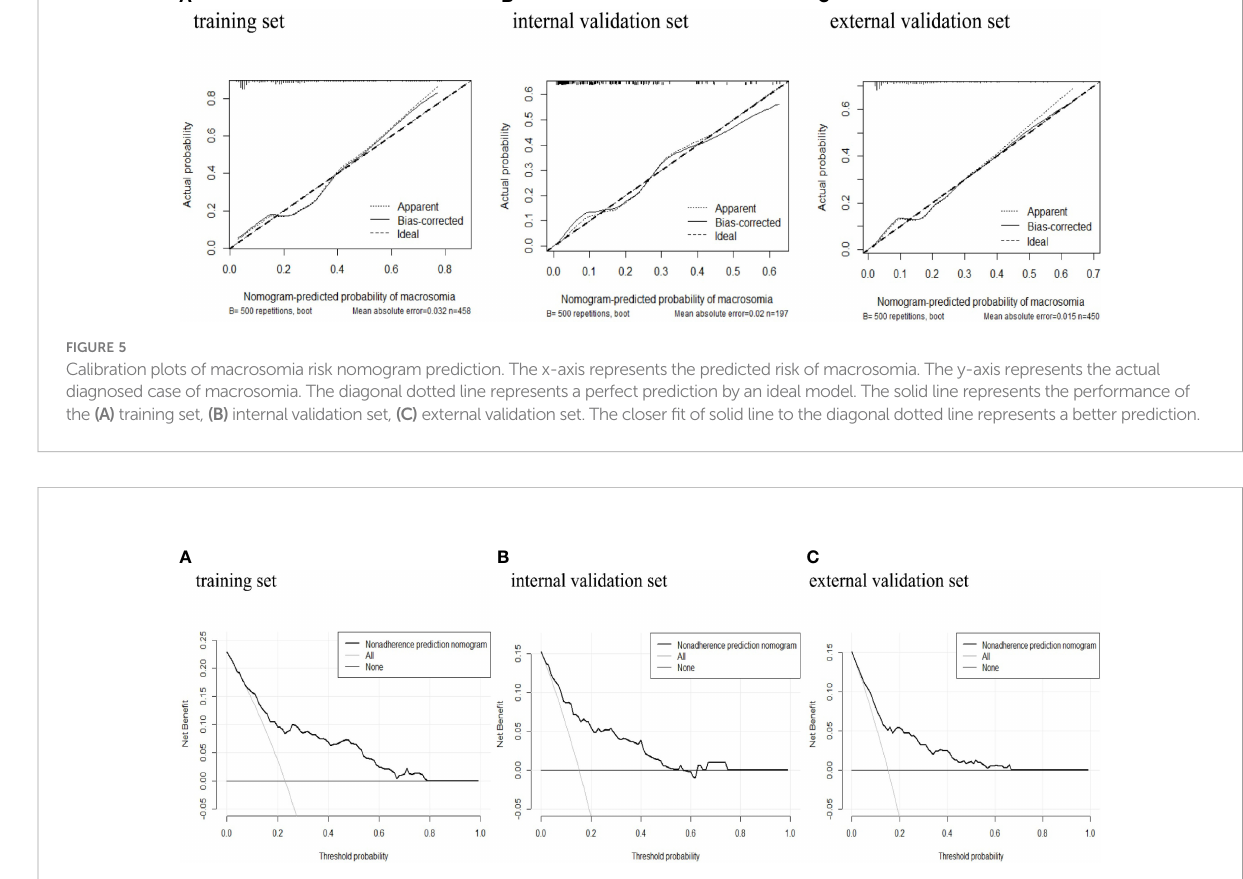
FIGURE 6 Decision curve analysis of macrosomia risk nomogram prediction. DCA of the (A) training set, (B) internal validation set, and (C) external validation set. The x-axis measures the threshold probability. The y-axis measures the net bene fi t. The thick, black solid line represents the macrosomia risk nomogram. The thin, black horizontal line (none line) represents the assumption that no patients are non-adherent to medication, which means that the net bene fi t is zero. The thin, gray bias (all line) represents the assumption that all patients are non-adherent to medication. DCA, decision curve